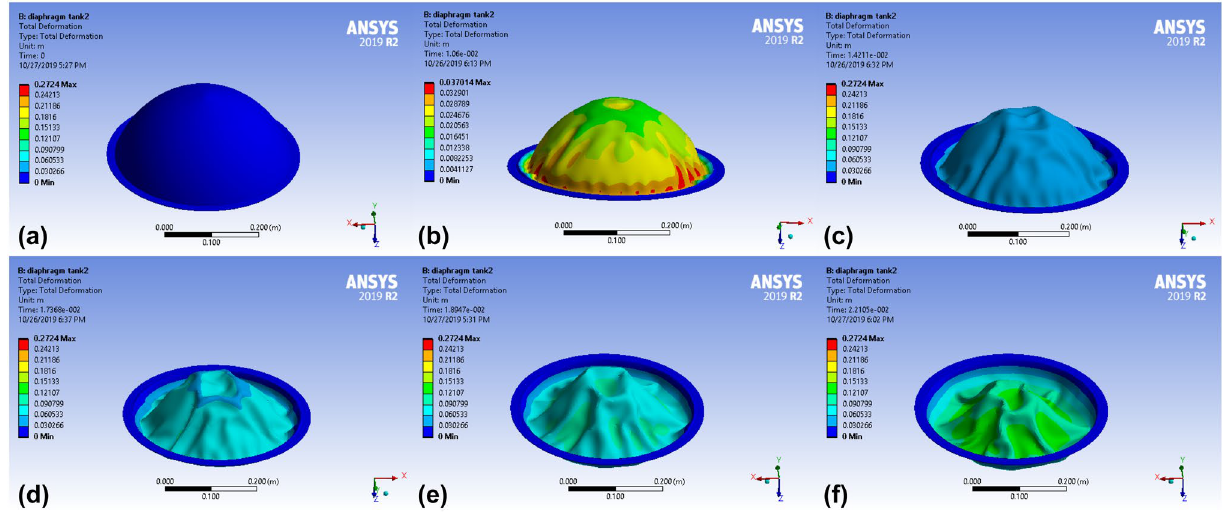
Fig. 10 Deformation of elastomer diaphragm from 50 to 100% ( a ) 100%, ( b ) 90%, ( c ) 80, ( d ) 70%, ( e ) 60%, ( f )